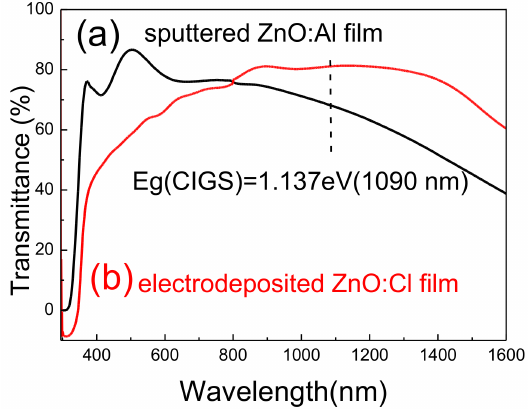
Figure 6. The transmittance of ( a ) sputtered ZnO:Al, and ( b ) electrodeposited ZnO:Cl films.